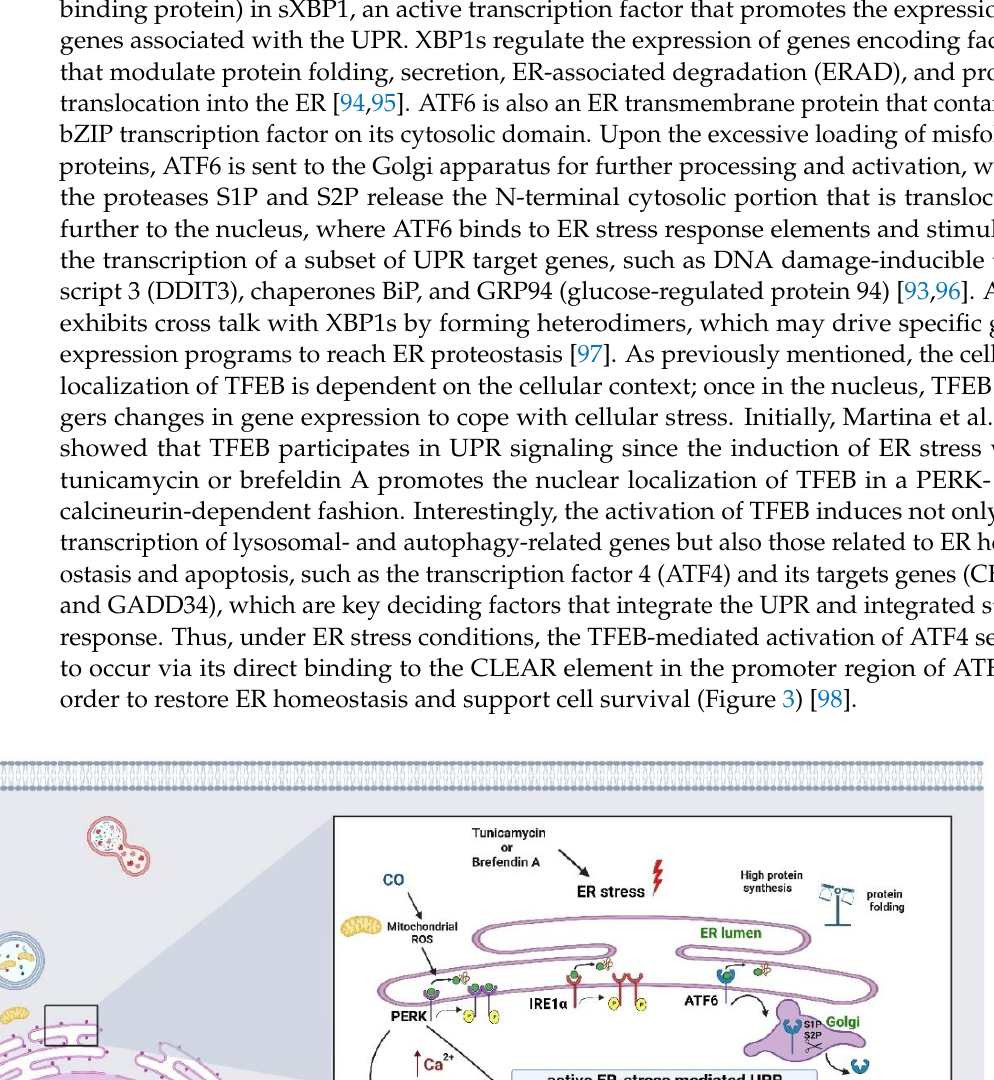
cells, where activated PERK led to an increase in cytosolic Ca 2+ levels that subsequently promoted the translocation of TEFB into the nucleus via the calcineurin-dependent dephosphorylation of TFEB. These findings suggest that the activation of PERK – TFEB sig- naling could decrease amyloidogenesis in neurodegenerative diseases [101]. It is well doc- umented that UPR increases ER cross talk with autophagy in each of the three canonical branches of the UPR, and it activates autophagy, which permits the restoration of ER ho- meostasis. Recent work by Zhang et al. [102] showed that the promoter of Tfeb possesses a consensus sequence recognized by the transcription factor sXBP1. Interestingly, a ChIP assay showed the enrichment of sXBP1 on the promoter of Tfeb in primary hepatocytes treated with thapsigargin and in the livers of fasted mice. Moreover, the overexpression of sXBP1 increases the nuclear localization of TFEB and induces autophagy flux; together, the data demonstrated that the ER and autophagy are functionally coupled at the tran- scriptional level via the XBP1-mediated activation of TFEB (Figure 3) [102]. Similar find- ings were made when several cell line cultures or rodent models were treated with distinct compounds such as Kazinol C, Isobacachalcone, DFS, or Guanabenz, respectively; these were able to activate ER stress-associated UPR components su ch as PERK, ATF6, IRE1α phosphorylation, BiP, CHOP, ATG7, GADD34, and sXBP1, as well as the nuclear translo- cation of TFEB and autophagy. However, the underlying molecular details remain un- known [103 – 106].